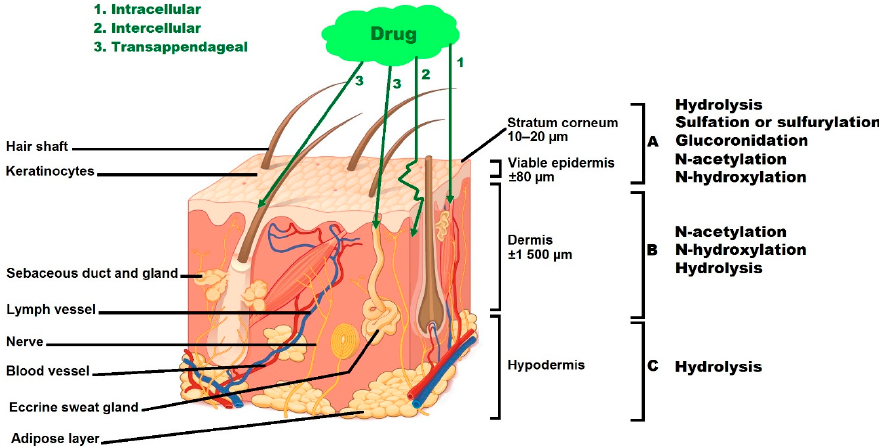
Figure 1. Drug penetration pathways (1, 2 and 3); sites of drug metabolism (a, b and c); and skin